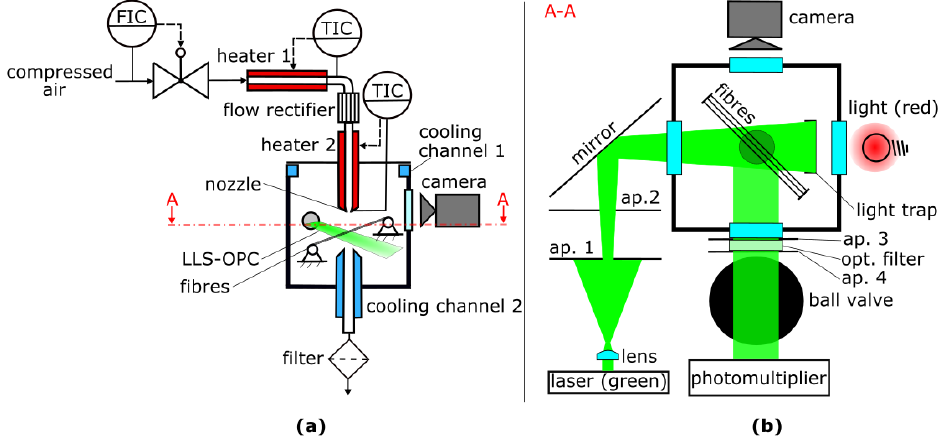
Figure 2. ( a ) Concept of the novel apparatus with the measurement chamber and the heated inlet; ( b ) Optical measurement system on the right side. The schematic diagram is not true to scale. Photographs of the novel apparatus and the fibres mounted in the inside of the measurement chamber are shown in Figure 3. The 40 µ m steel fibres can be mounted in 25 different holes with 170 µ m diameter at a centre-to-centre distance of 246 µ m and tensioned using a weight fixed at one end of the fibres.